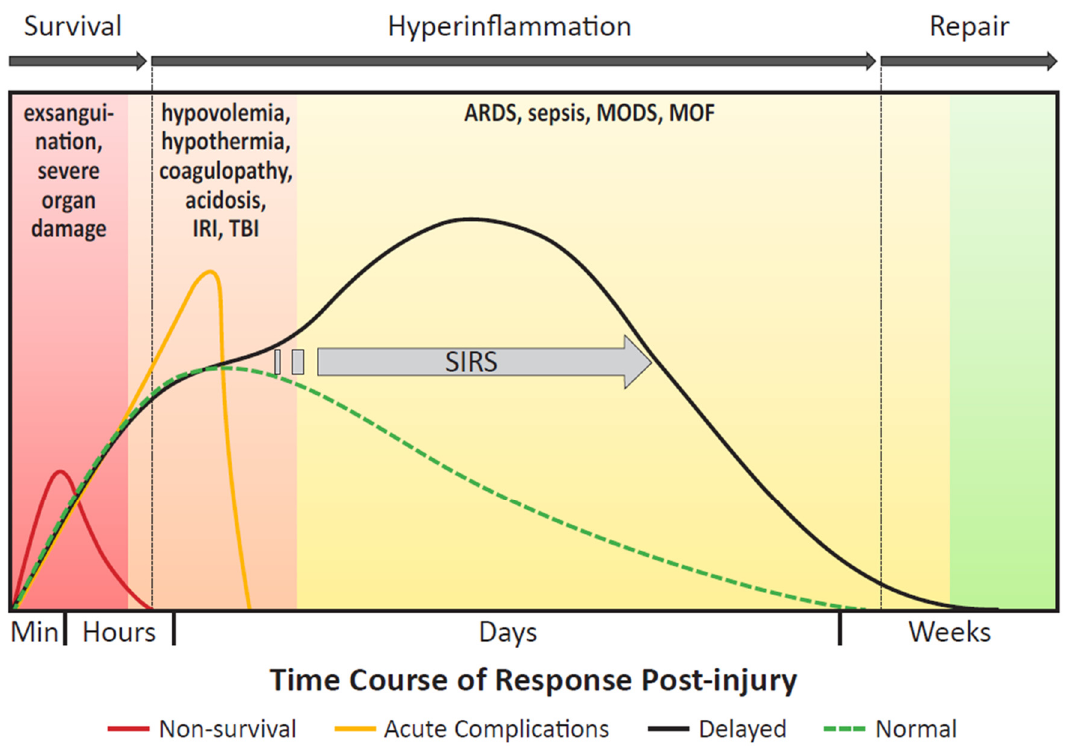
Figure 2. Response to traumatic injury. The three phases following injury are identified by the arrows at the top of the timeline: survival, hyperinflammation, and repair. The longer the hyperinflammation phase is extended, the more delayed the initiation of the repair phase, contributing to late term healing complications. The text beneath the response phase arrows lists various complications associated with increased mortality during the course of the body’s response to trauma—the majority of these conditions after the survival phase are caused by or related to inflammation. The dotted green line shows a “normal” appropriate, restrained inflammatory response that begins to resolve a few days after injury. The red curve represents non-survival—patients that will expire immediately following injury or within the earliest phases of care due to insurmountable injuries and exsanguination. These patients will fail to survive long enough to amount a robust inflammatory response. The orange curve represents patients that will be lost in the first few days of care, usually due to complications related to resuscitation, including ischemic reperfusion injury (IRI), or injury severity, especially in the setting of traumatic brain injury (TBI). The black curve encompasses the patient population that will experience delayed trauma-associated hyperinflammation-induced complications, beginning several days after the initial injury. Dysregulation of the inflammatory response or further insults will cause a patient to deviate from normal recovery, making them more susceptible to the development of systemic inflammatory response syndrome (SIRS), or infection that may cause further complications or death.